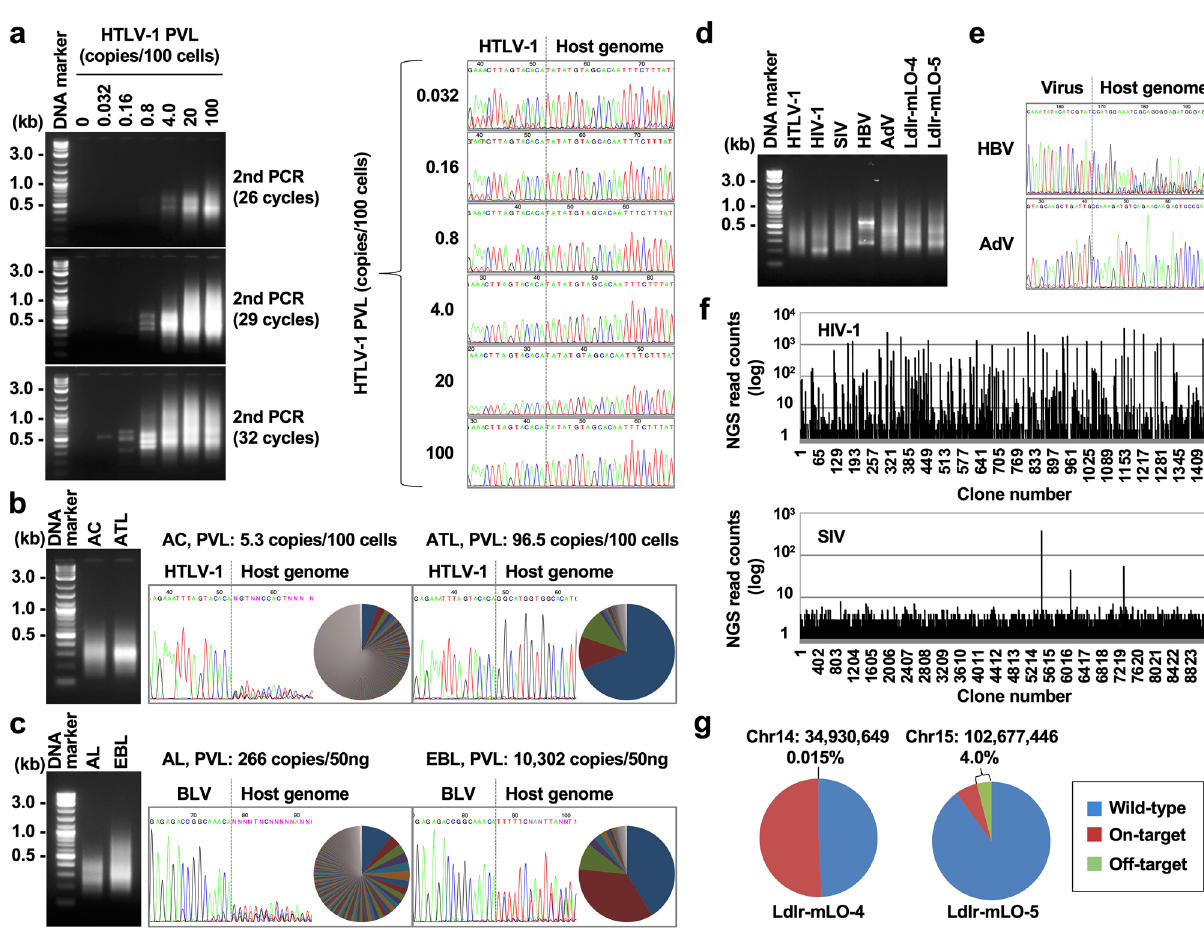
Fig. 2 Performance of Rapid Ampli fi cation of Integration Site without Interference by Genomic DNA contamination (RAISING). All RAISING products were visualized by electrophoresis on 2% agarose gels. Dotted lines in Sanger sequencing spectra indicate the position of transgene integration sites. a The sensitivity of RAISING was assessed by serially diluting TL-Om1 genomic DNA (an HTLV-1-infected cell line harboring a single copy of HTLV-1) with Jurkat genomic DNA (an HTLV-1 negative cell line). Even extremely diluted samples (resulting in PVL as low as 0.032) could be detected by increasing the cycles in the second PCR of RAISING (left panel). Sanger sequencing analysis of RAISING products con fi rmed that the same integration site was identi fi ed in every dilution (right panel). PVL proviral load. b , c Clonality analyses of infected samples using Sanger sequencing (spectra) vs. high throughput sequencing (HTS, pie charts) showed similar results. b HTLV-1 clonality analysis of an asymptomatic carrier (AC) and an adult T-cell leukemia/lymphoma (ATL) patient. c Bovine leukemia virus (BLV) clonality analysis of an aleukemic (AL) cow and a cow with enzootic bovine leukosis (EBL). d Successful ampli fi cation of various transgene-integrated fragments (HTLV-1; HIV-1 human immunode fi ciency virus, SIV simian immunode fi ciency virus, HBV hepatitis B virus, AdV adenovirus, and low-density lipoprotein receptor knock-in mice Ldlr-mLO-4 and Ldlr-mLO-5) with RAISING. e HBV and AdV integration sites. f Clonality analysis of HIV-1 and SIV-infected cells with HTS analysis. HTS read counts indicate the size of each clone. g RAISING with HTS analysis was used to identify on- and off-target effects in Ldlr-mLO-4 and Ldlr-mLO-5 knock-in mice established by genome editing technology. Chr,